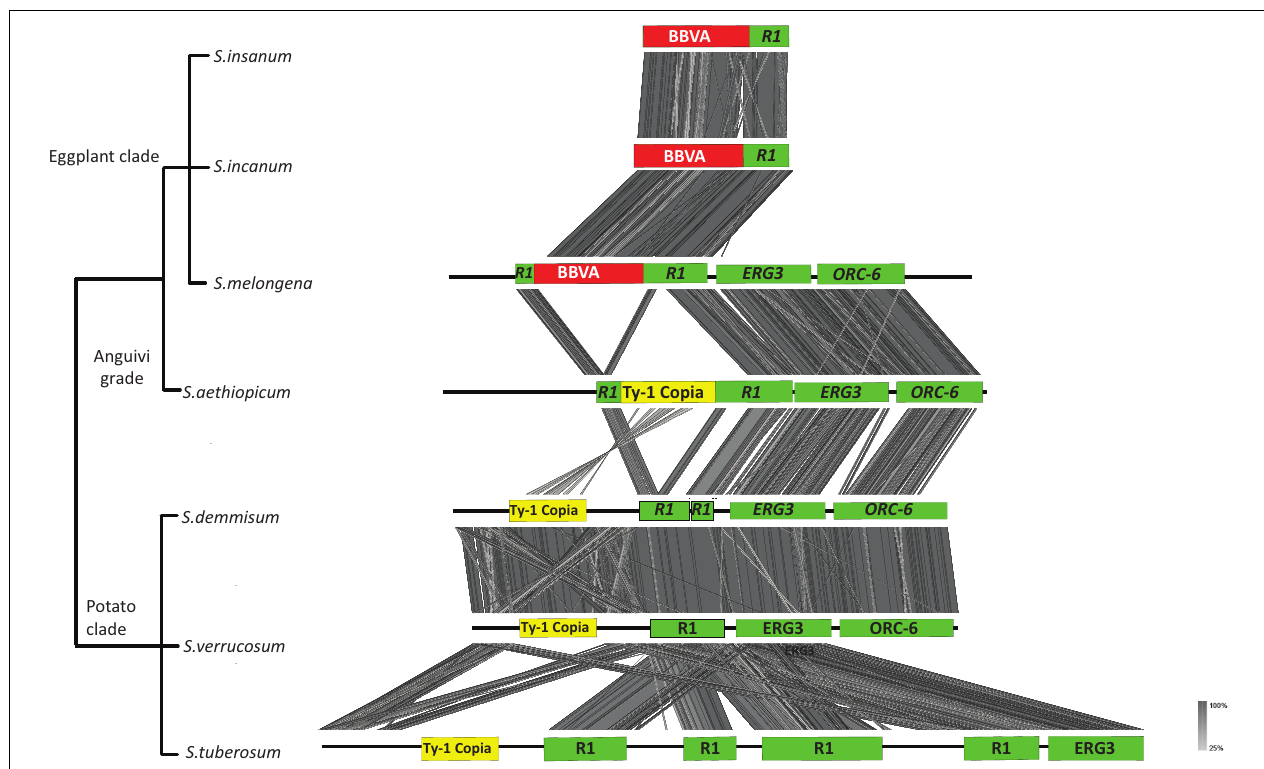
FIGURE 4 | Syntenic relationships between S. melongena V R1 locus and homologous genomic regions of related Solanum species. Viral sequences are shown in red and host sequences are shown in green. Ty-1 copia transposable elements are shown in yellow boxes. ERG3: sterol-C5(6)-desaturase; ORC-6: origin recognition complex